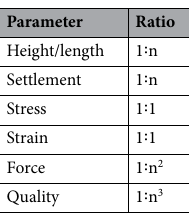
Table 4. Similitude ratios (the ratio is n).